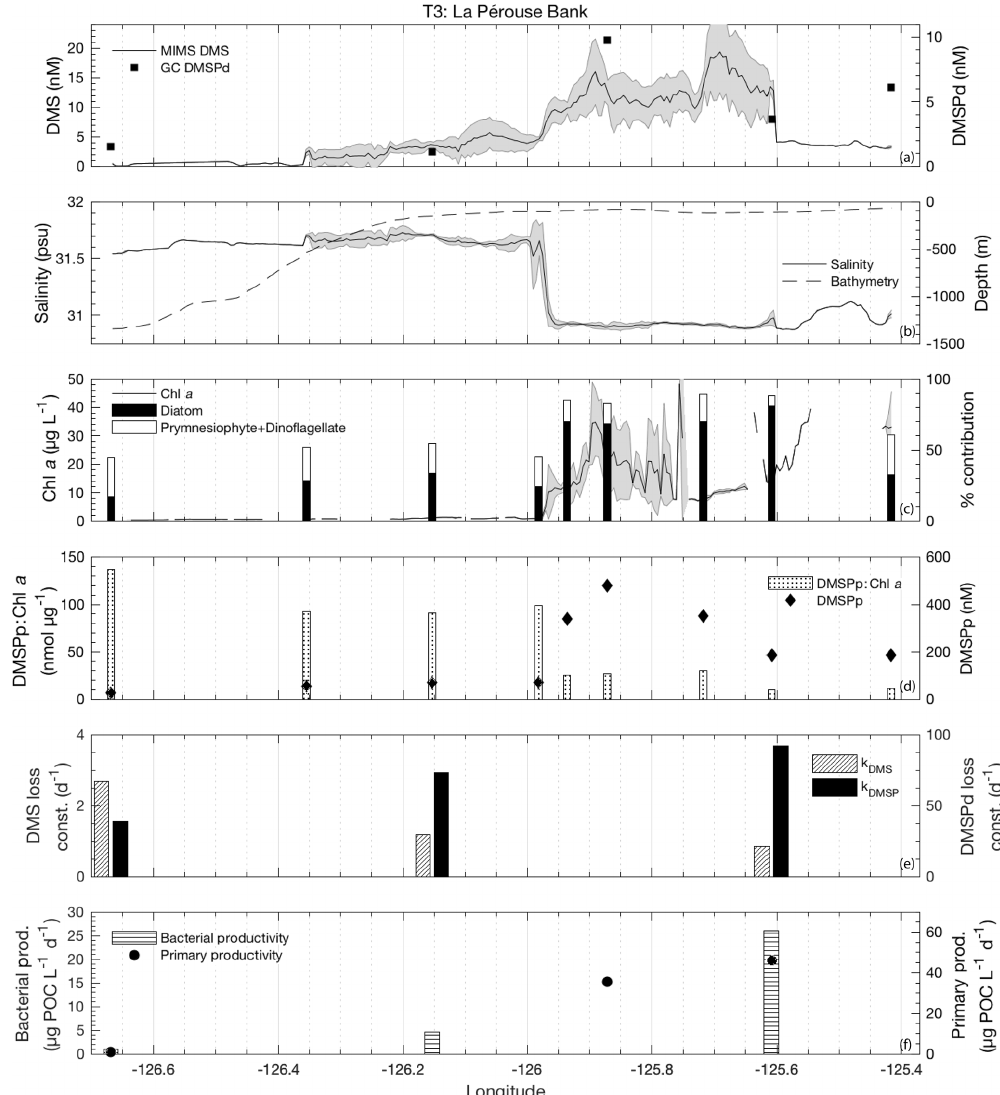
Figure 7. The same as Figs. 4 and 6 but for the T3